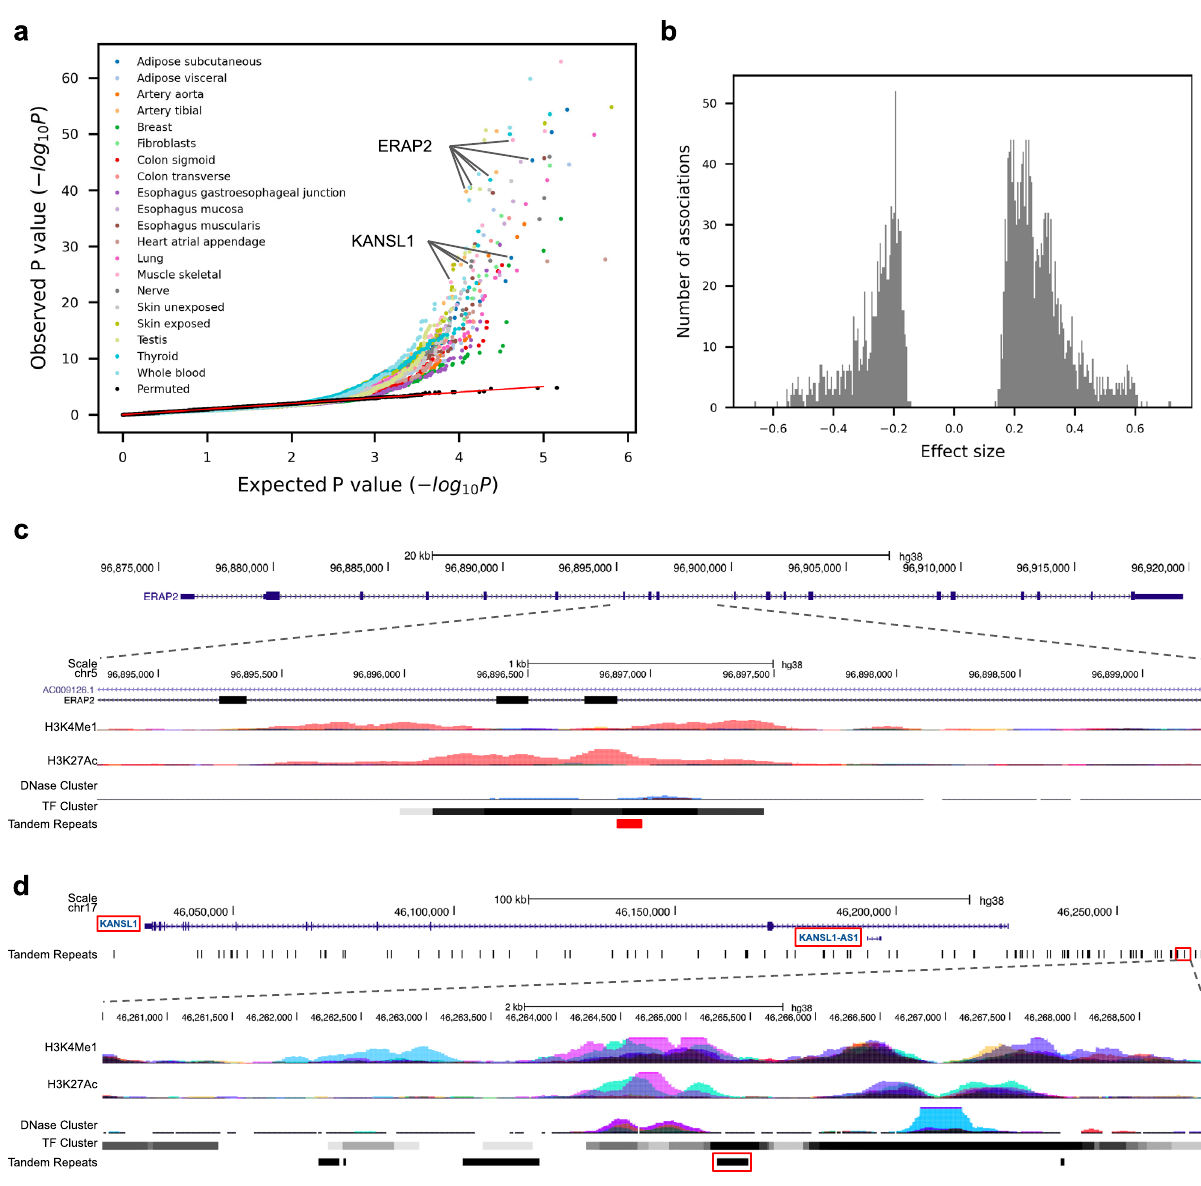
Fig. 5 cis -eQTL mapping of VNTRs. a eVNTR discoveries in 20 human tissues. The quantile-quantile plot shows the observed P- value of each association test (two-sided t -test) versus the P -value drawn from the expected uniform distribution. Black dots indicate the permutation results from the top 5% associated (gene, VNTR) pairs in each tissue. The regression plots for ERAP2 and KANSL1 are shown in c and d . b Effect size distribution ( n = 2510) of signi fi cant associations from all tissues. c , d Genomic view of disease-related (eGene,eVNTR) pairs ( ERAP2 , chr5:96896863 – 96896963) ( c ) and ( KANSL1 , chr17:46265245 – 46265480) ( d ) are shown. Red boxes indicate the location of eGenes and